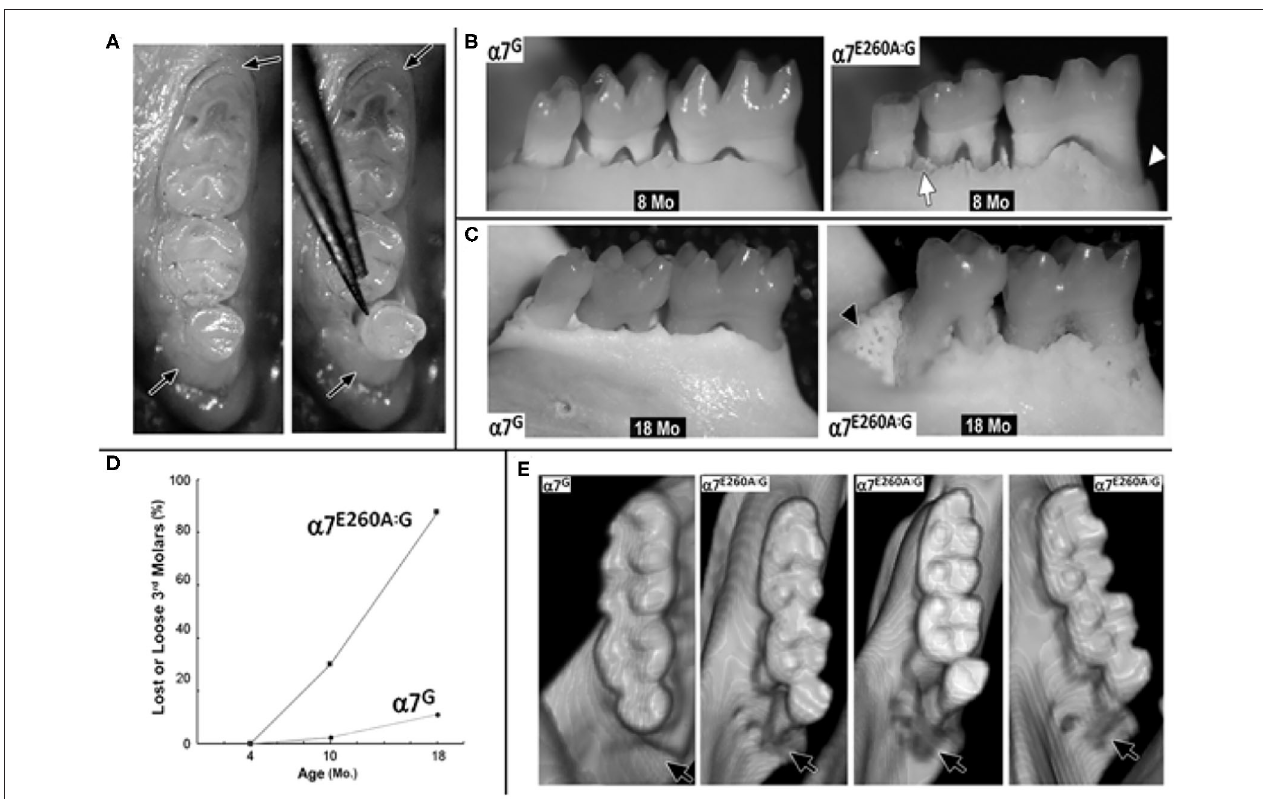
FIGURE 1 | Age-associated increase in 3rd molar looseness and micro-CT images of bone loss in the α 7 E260A : G mandible. (A) Example of 3rd molar looseness before (left panel) and its displacement with light pressure from forceps (right panel). Arrows point to soft tissue surrounding the teeth. (B) Defleshed mandibles from 8 month-old (8 Mo) α 7 G or α 7 E260A : G mice. Bone loss around the 1st molar root (arrowhead) and porous (cancellous-like) appearance of bone surrounding teeth (arrow). (C) Similar images of 18 month-old (18 Mo) mandibles. Note loss of 3rd molar in the α 7 E260A : G and cancellous appearance of bone replacing the lost molar (arrowhead, 18 mo α 7 E260A : G ). (D) Quantitation of loose or missing 3rd molars in mandibles of 4 month ( N = 30 each genotype), 8–10 month ( N = 40 each genotype) and 18 month old mice ( N = 18, α 7 G and N = 16, α 7 E260A : G ). (E) Micro-CT rendered images of the mandibular molars from an α 7 G mouse (8 mo) or several 8 month old α 7 E260A : G mice that exhibited a loose 3rd molar. Arrows point to the bone socket and most common site of